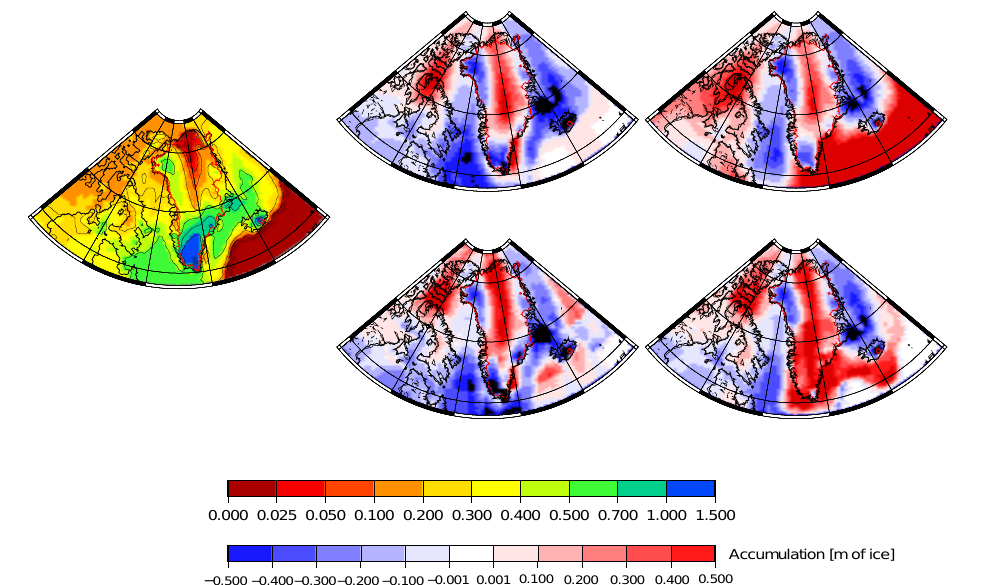
Figure 13. Differences in accumulation between the climatology (a) , and the snow accumulation method in the CTRL (b) , the precipitation accumulation method in the CTRL (c) , the SNOW (d) and the PRECIP (e)